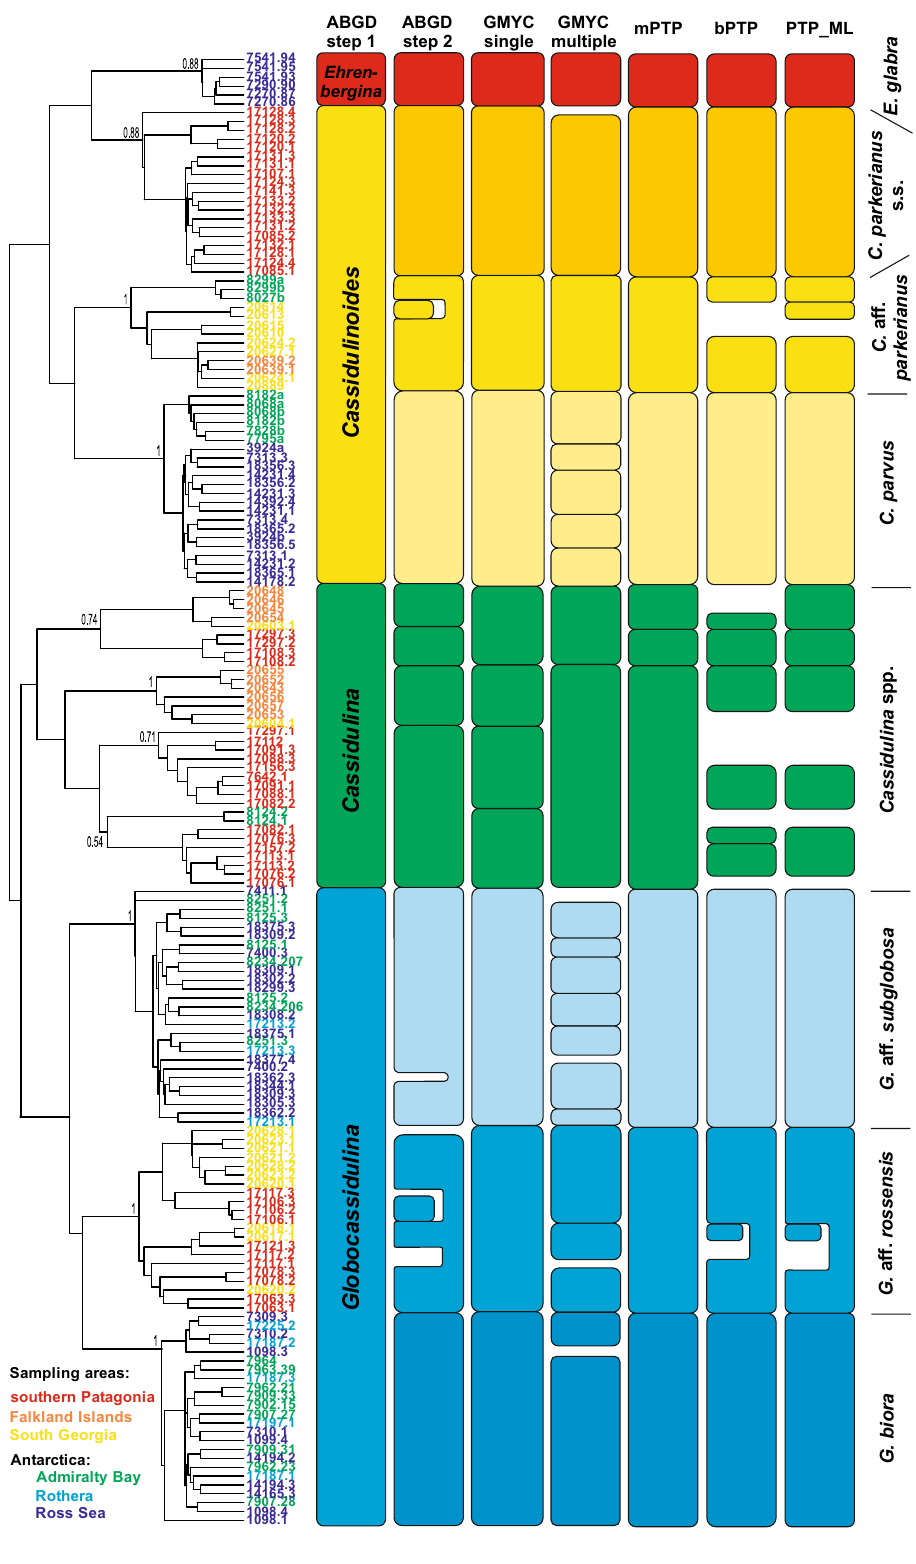
Figure 2. Molecular operational taxonomical units (MOTUs) or species, marked by shades of different colors, based on six different species delimitation analyses. MOTUs with single sequences not indicated. Bayesian ultrametric tree is based on haplotype data reconstructed in BEAST 2.5. Sequence numbers are colored according to sampling